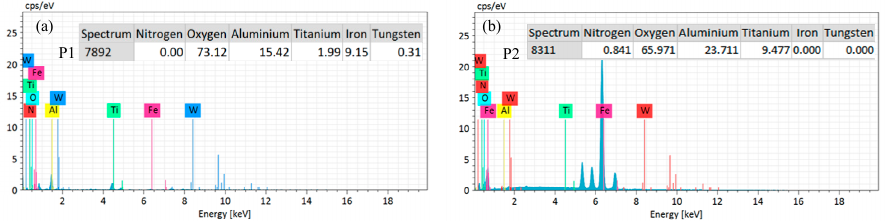
Figure 19. ( a ) EDS analysis point P1 of Tool A in Figure 17. ( b ) EDS analysis point P2 of Tool A in Figure 17.